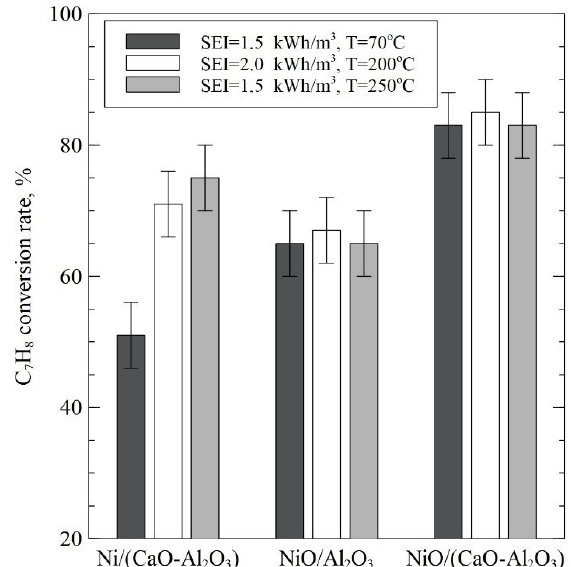
Figure 2. Effect of SEI and temperature on toluene conversion. Initial toluene concentration 4500 ppm, series A.